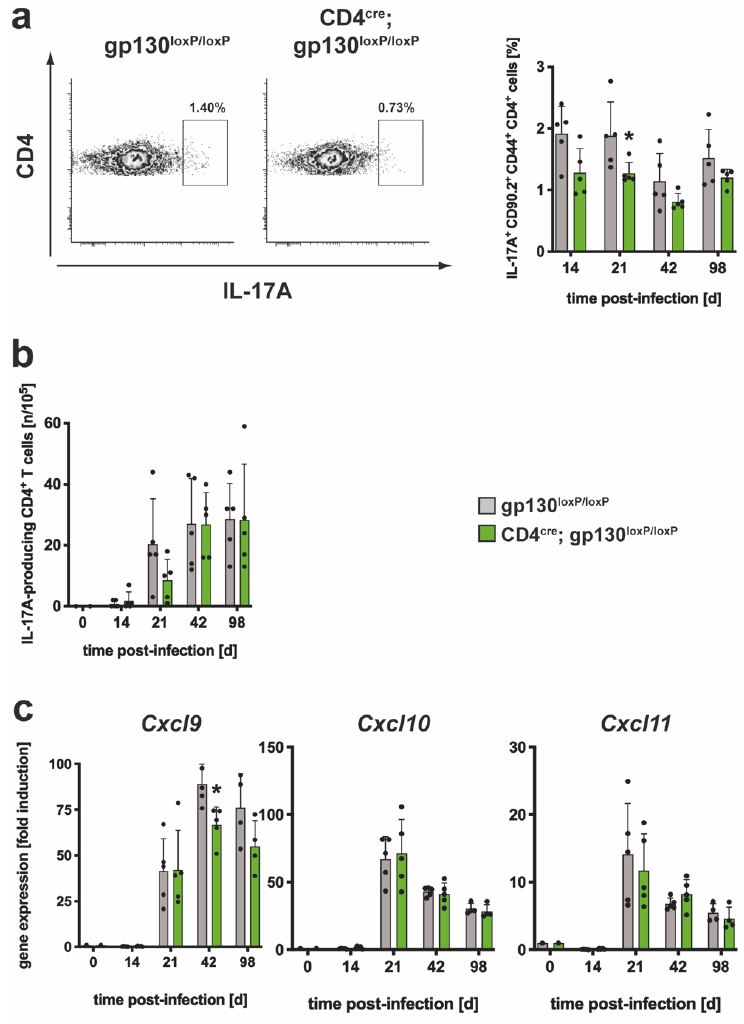
Figure 5. The TH17 immune response in CD4 cre ; gp130 loxP/loxP mice during experimental TB. gp130 loxP/loxP (grey symbols) and CD4 cre ; gp130 loxP/loxP mice (green symbols) were infected with approximately 100 CFU Mtb via the aerosol route. At the indicated time points, lungs were removed and further processed. ( a ) The relative amount of IL-17A-producing CD4 + CD44 + CD90.2 + T cells was determined in single cell suspensions of lungs by flow cytometry after restimulation with anti- CD3/CD28. Representative density plots of IL-17A-producing CD4 + CD44 + CD90.2 + T cells on day 42 and frequencies of IL-17A-producing CD4 + CD44 + CD90.2 + T cells during the course of infection are shown. ( b ) CD4 + T cells were purified from lung cell suspensions by MACS and restimulated